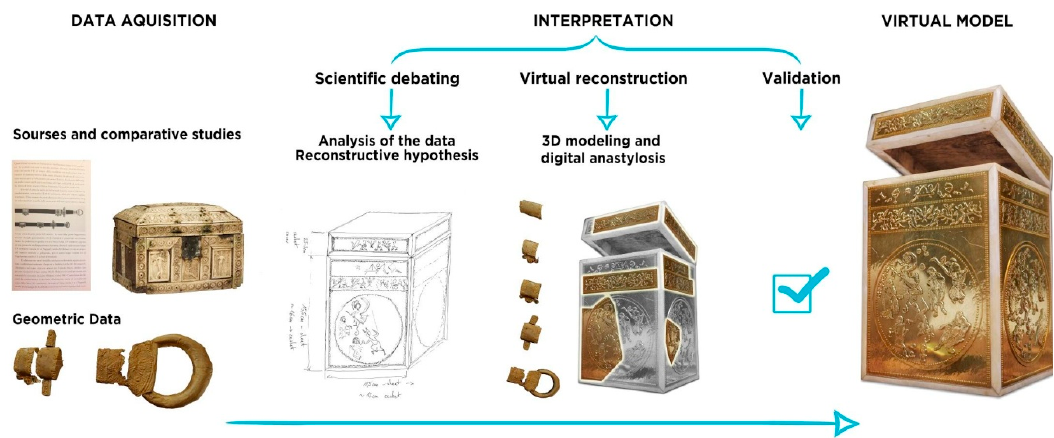
Figure 16. Virtual reconstruction workflow, from data acquisition to virtual models ready to be used for visualization and communication.